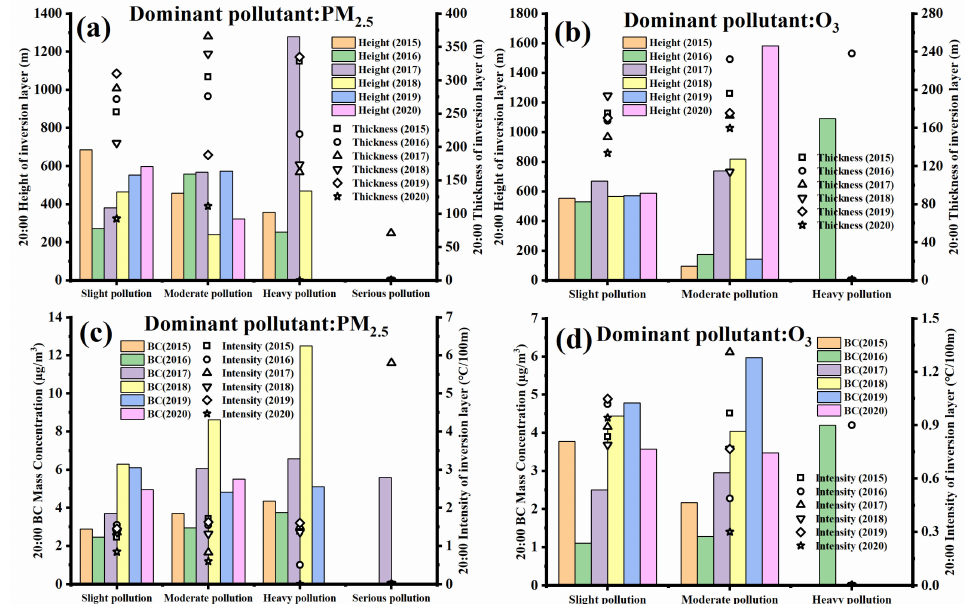
Figure 6. ( a ) Annual variations in inversion layer height and inversion layer thickness at 20:00 for